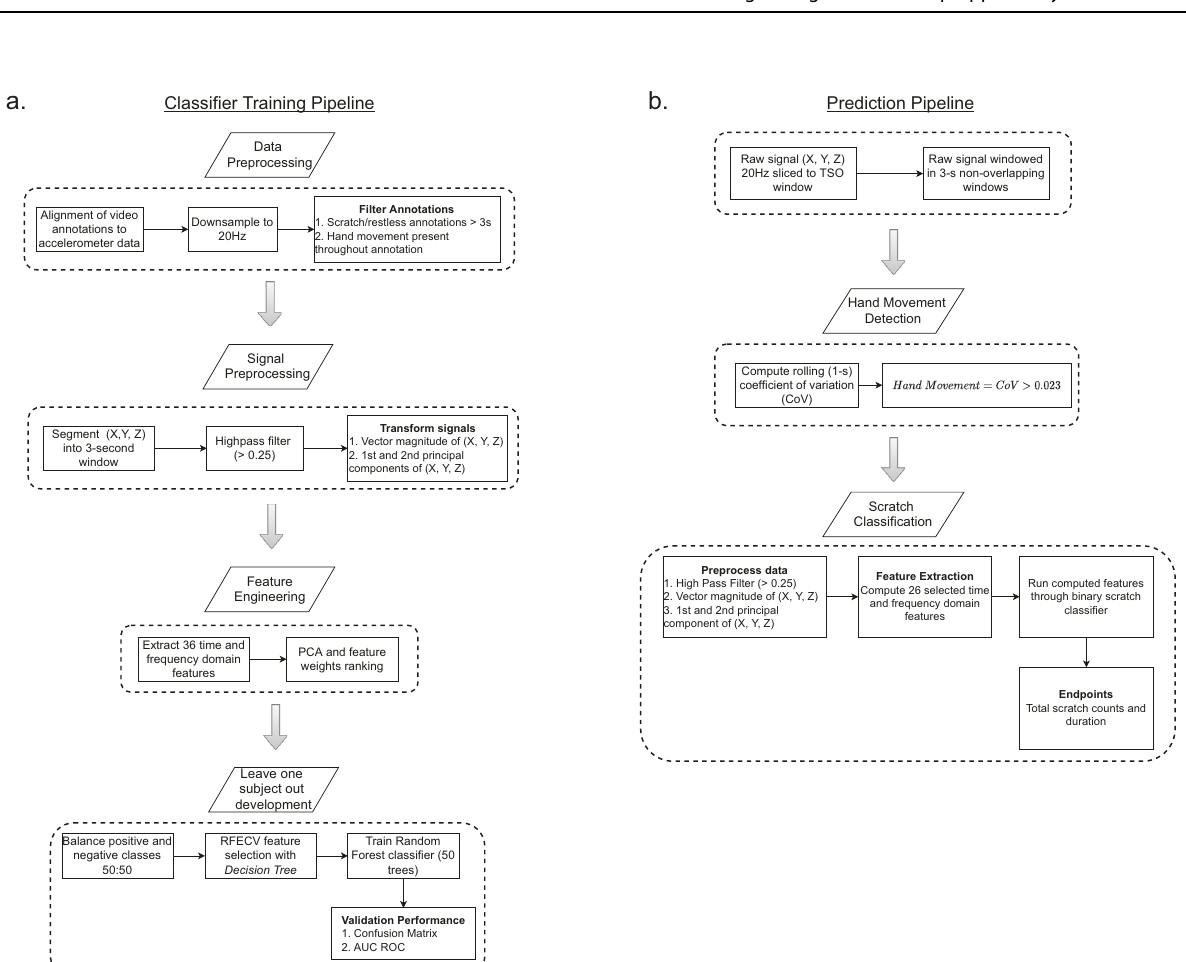
Fig. 5 Overview of the prediction and classi fi er training pipeline for the scratch module. a Scratch classi fi er training pipeline, consisting of data preprocessing, signal preprocessing, feature engineering, and leave-one-subject-out validation. b Scratch module prediction pipeline, consisting of data preprocessing, hand movement detection, scratch classi fi cation, and scratch